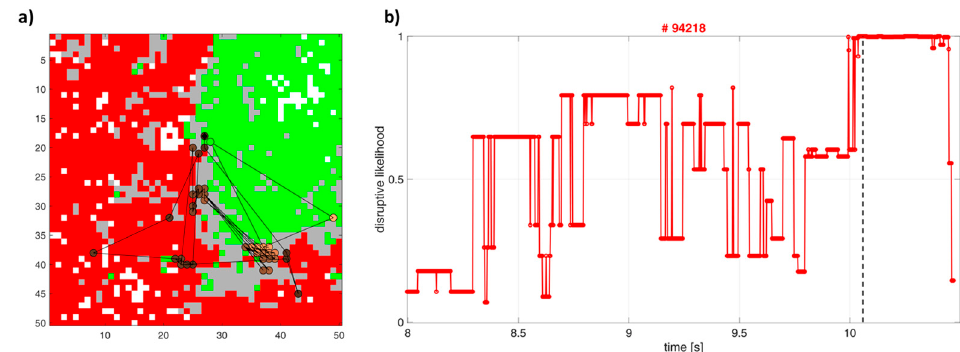
Figure 5. ( a ) GTM map of JET operational space with trajectory of the disrupted discharge #94218; ( b ) disruptive likelihood of the disrupted discharge #94218. The dashed black line identifies the alarm time. Table 5. GTM training parameters.